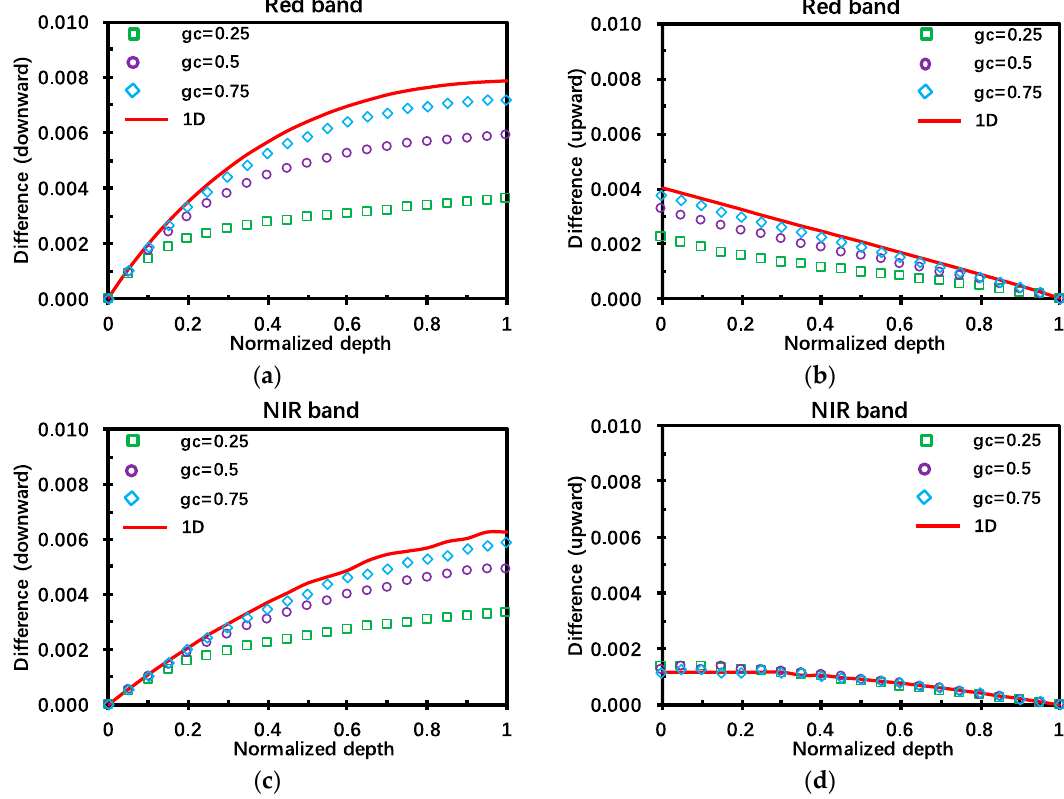
Figure 5. Difference between mean radiation flux densities when the leaf surface reflection is accounted for and when it is neglected (i.e., leaves are bi-Lambertian scatters) over the entire horizontal plane at red ( a , b ) and near infrared ( c , d ) bands for four types of ground cover conditions. ( a , c ) denote the vertical profiles of downward differences, whereas ( b , d) represent that of upward differences. Solid lines correspond to the 1D vegetation canopy ( gc = 1.0) and symbols represent gc = 0.25, 0.5, and 0.75, respectively. Other parameters are the same as in Figure 4.